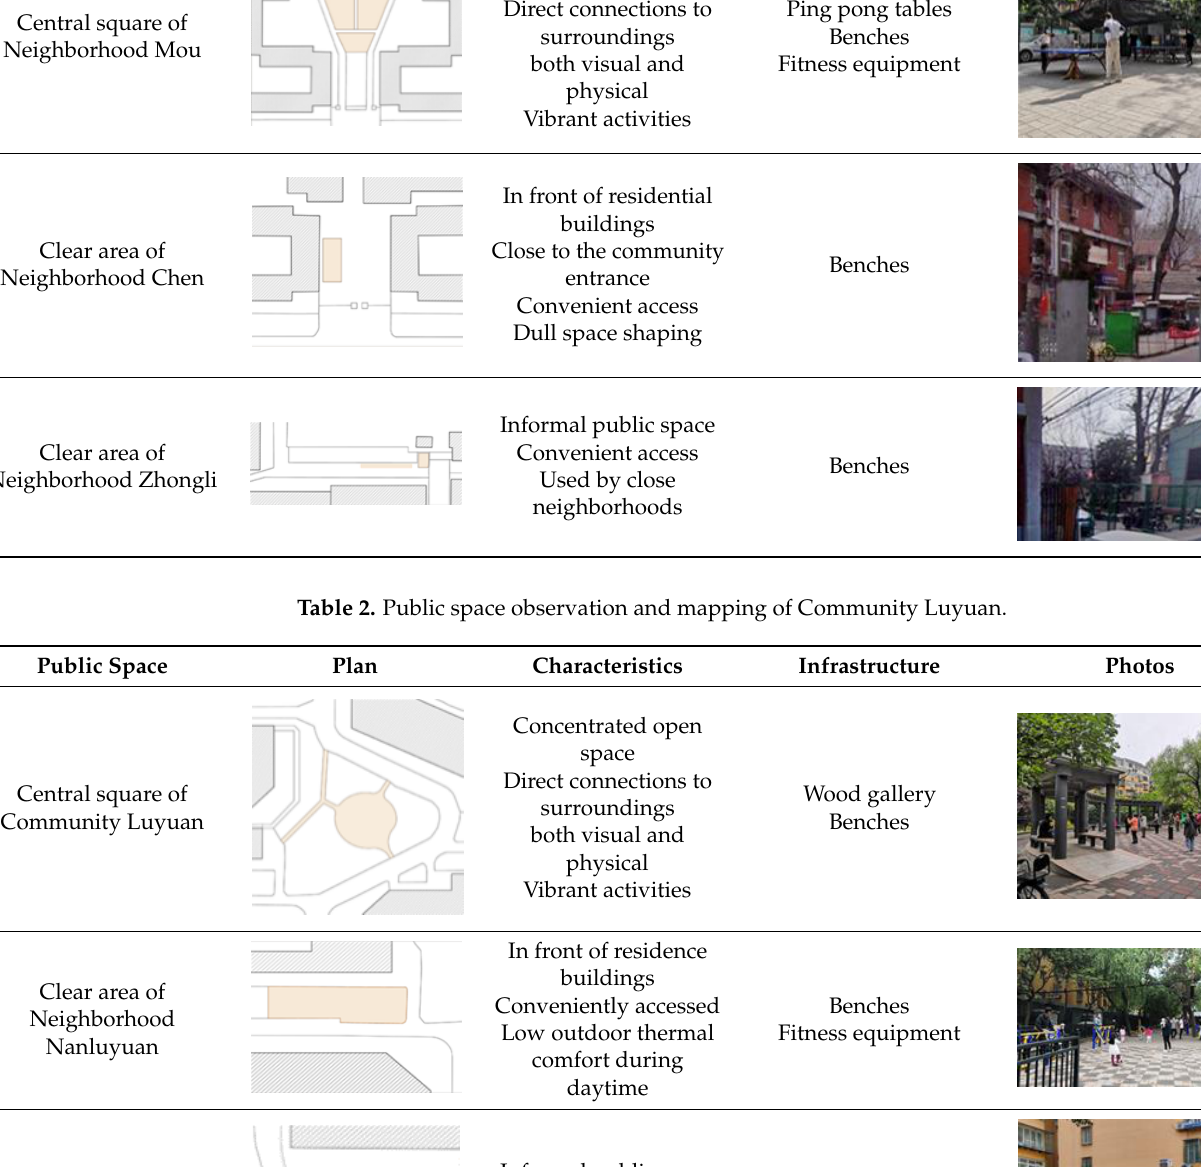
Table 2. Public space observation and mapping of Community Luyuan.